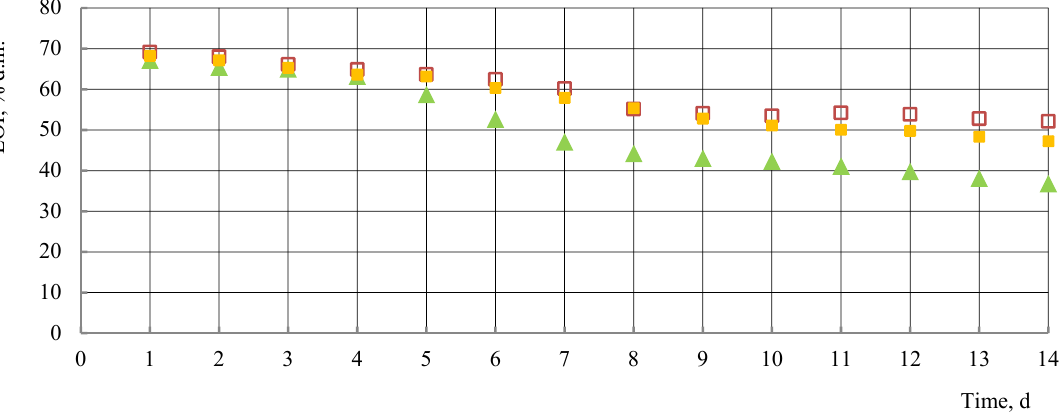
Figure 6. The loss on ignition of the waste registered during the 14 day cycle of the biodrying process in the different parts of the reactor.